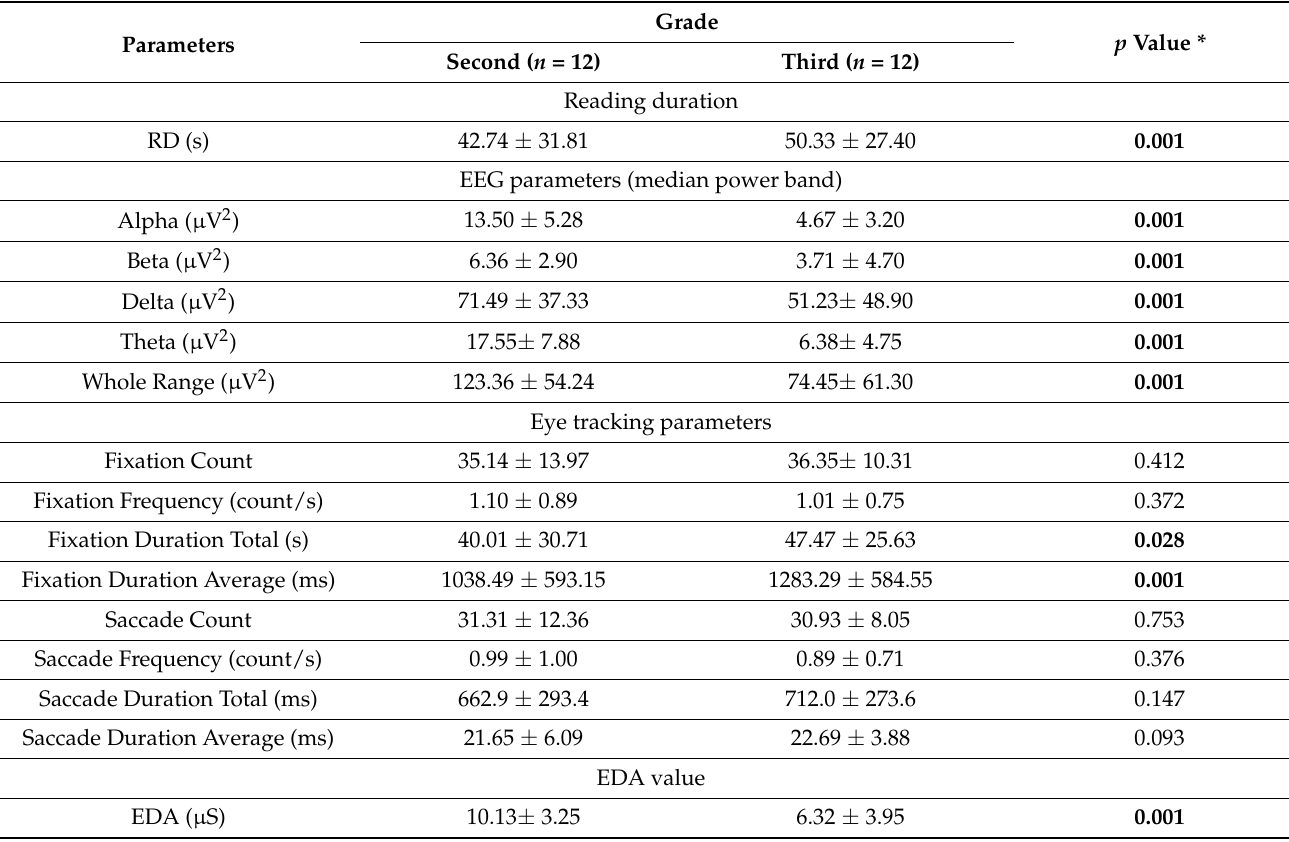
Table 4. Reading duration, EEG, eye tracking and EDA parameters in second and third grade across all colors together— significant p values are marked in